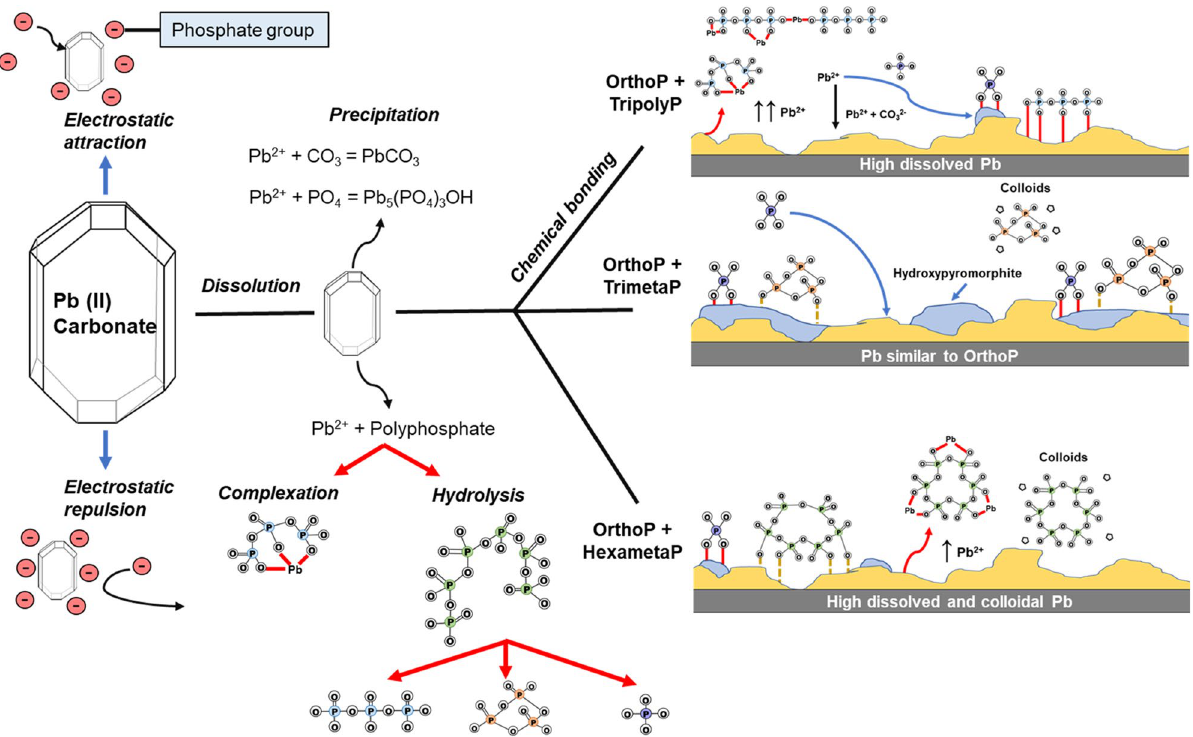
Figure 9. Schematic representation of phosphate-lead interaction mechanisms. Bonding information was sourced from Michelmore et al. 31 , and Rashchi and Finch 38